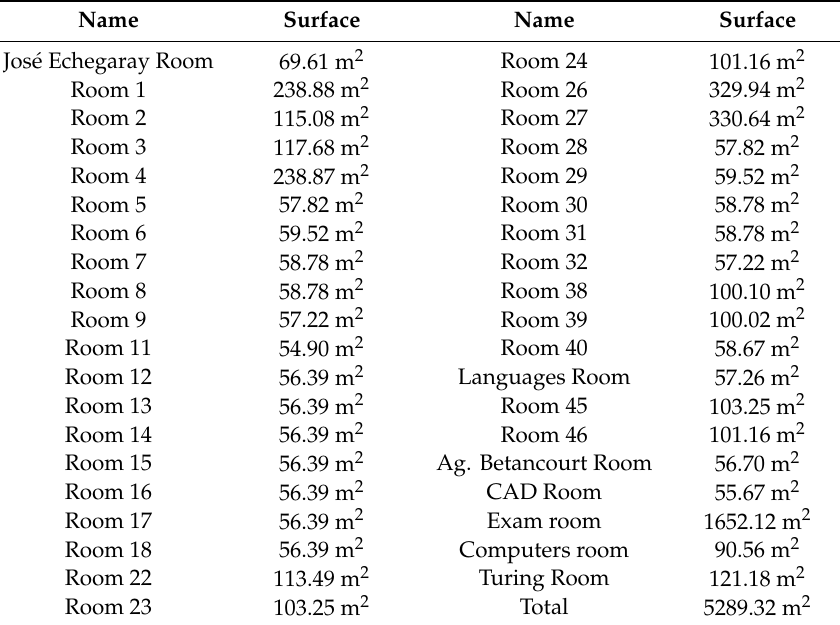
Table 1. Surface of teaching